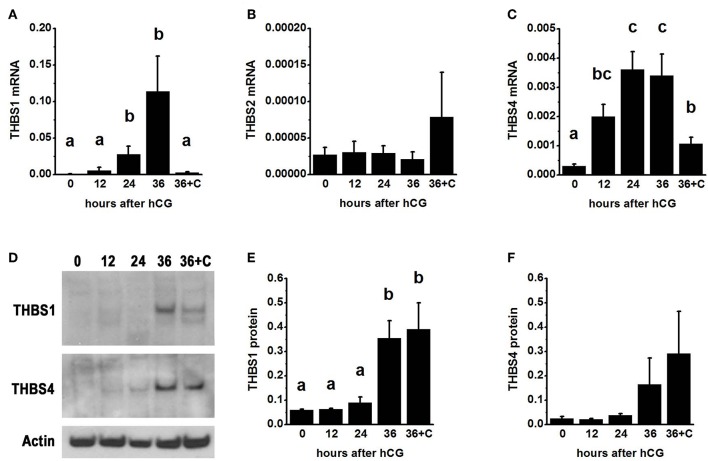
Thrombospondin production by the ovulatory follicle. Granulosa cells were aspirated from monkey ovarian follicles after ovarian stimulation before (0), 12, 24, or 36 h after administration of an ovulatory dose of hCG; additional monkeys received hCG and the PTGS2 inhibitor celecoxib (36+C) 36 h before follicle aspiration. Granulosa cells were assessed by qPCR for mRNA levels of THBS1
(A), THBS2
(B), and THBS4
(C). All THBS mRNA levels are expressed relative to BACT. Granulosa cell lysates were assessed for THBS1 (D,E) and THBS4 (D,F) by western blotting and are expressed relative to pan-actin (D). For (A–C,E,F), data are expressed as mean + SEM, n = 3–7 samples/treatment. Within each panel, groups with no common letters are different by ANOVA and Duncans post hoc test, p < 0.05.